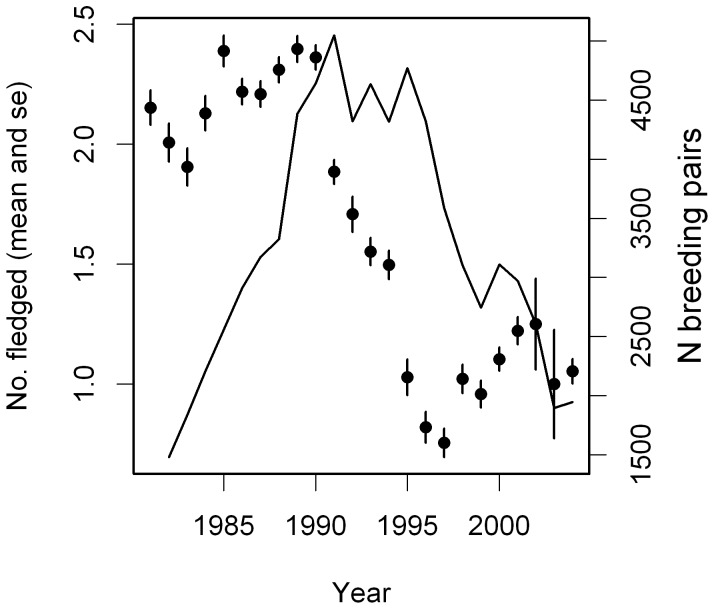
Changes in reproductive success and population numbers during the study period.Mean ± se of annual reproductive success at the Vorsø colony (filled circles), and number of breeding pairs (solid line) for the period 1981 until 2004.